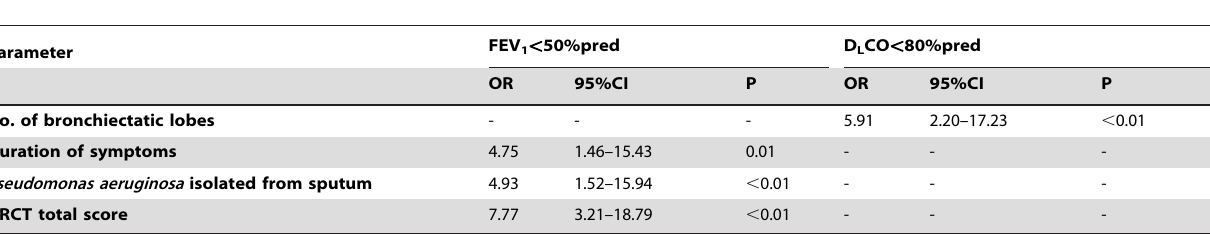
Table 3. Multivariate model for the factors associated with FEV 1 , 50%pred and D L CO , 80%pred. coagulase-negative staphylococcus. Prolonged culture was done for